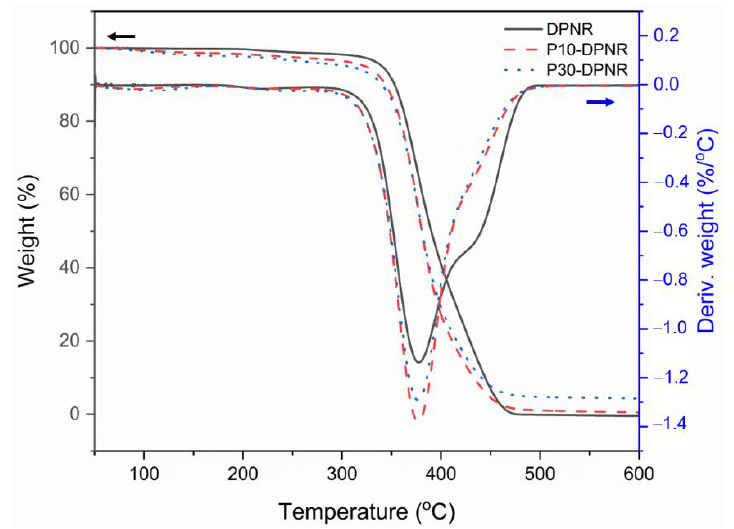
Figure 8. TGA and DTG thermograms of DPNR, P10-DPNR, and P30-DPNR.